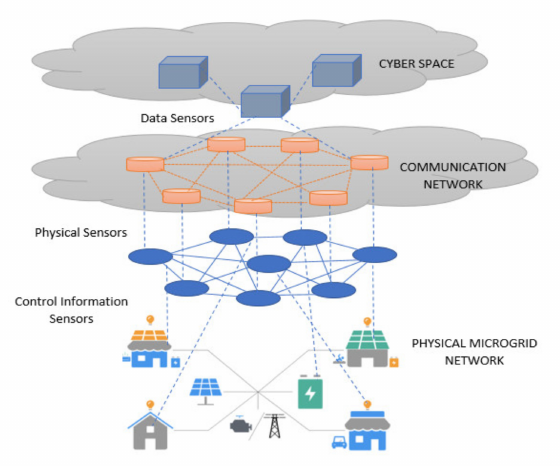
Figure 1. Structure of a microgrid